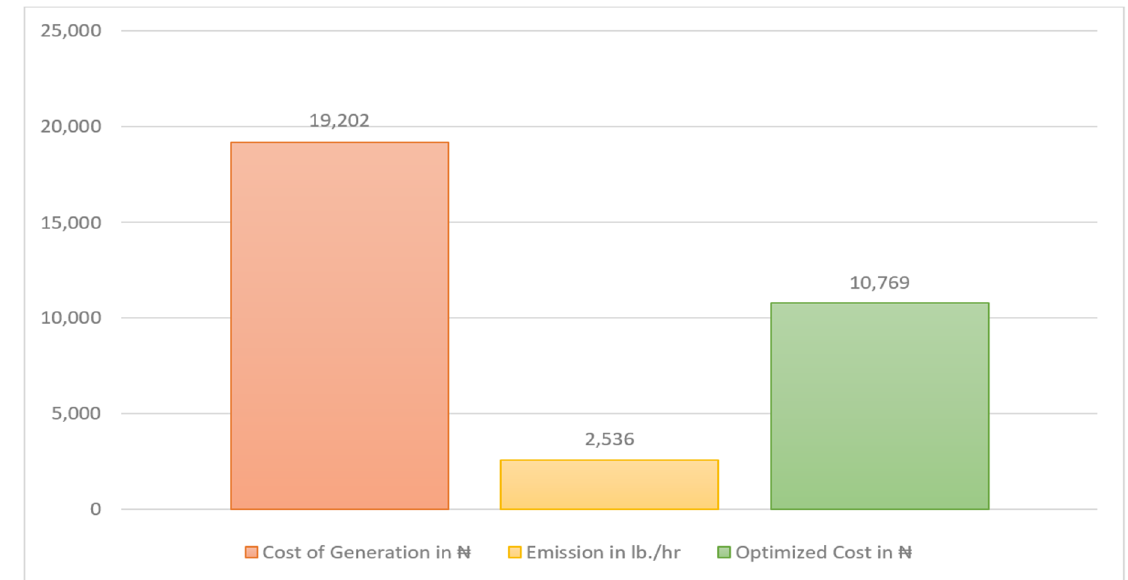
Figure 4. Case 1: Performance evaluation of economics and emissions.